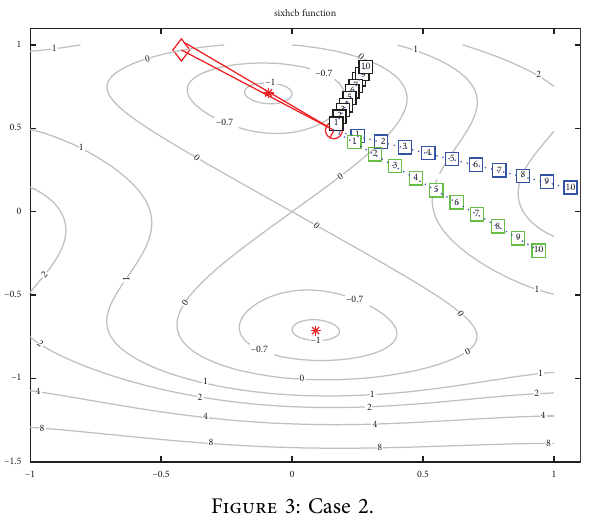
Figure 3: Case 2.